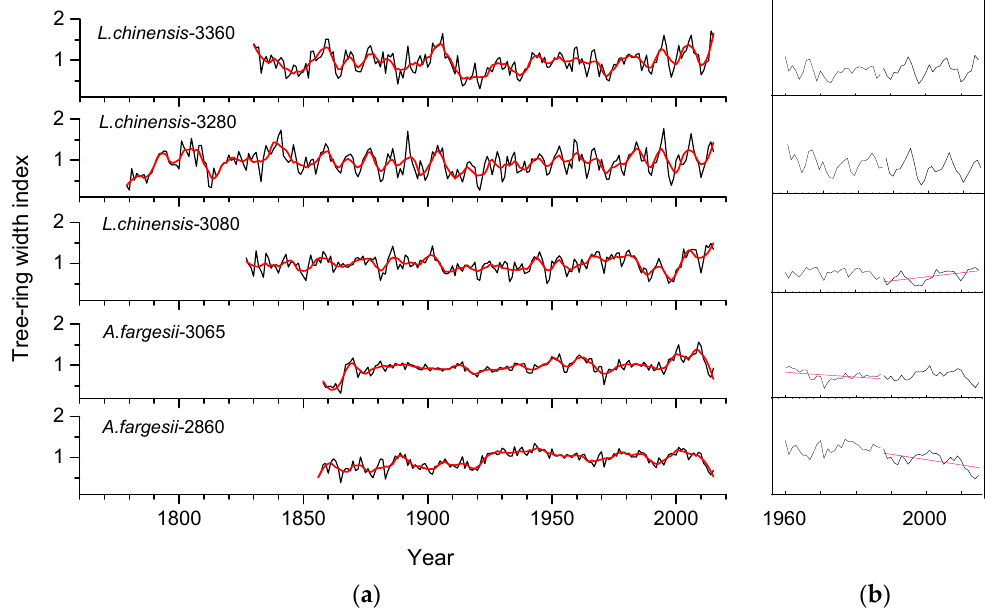
Figure 3. Indexed tree-ring width standard chronologies ( a ) of L. chinensis (larix) and A. fargesii (fir) along the elevational gradient and ( b ) corresponding tree-ring width data (in mm) since 1960 (plots displayed within the box). In the plot ( a ) thin (black) and bold (red) lines indicate annual values and 10-year moving averages, respectively. Numbers indicate the elevation (in m) of sampled stands. In plot ( b ) the red lines indicate significant ( p < 0.05) trends of tree-ring width.